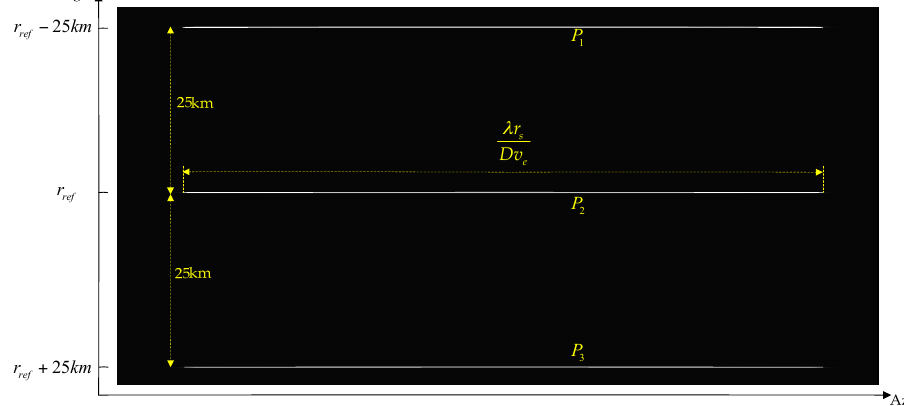
Figure 10. Time aliasing compensation results by adopting range-dependent deramp.